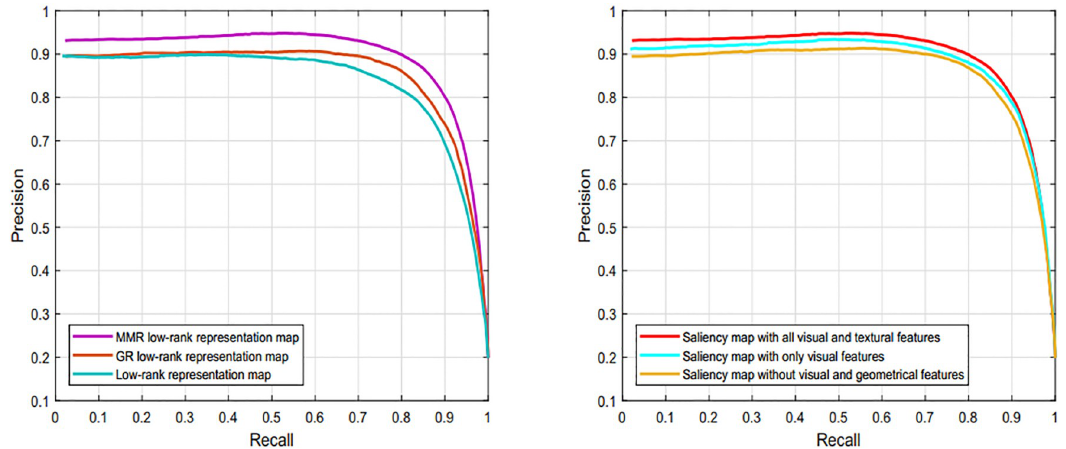
Fig 8. The soundness and efficiency of proposed model through the visual features, textural features and different regularization terms using the MSRA dataset [38].